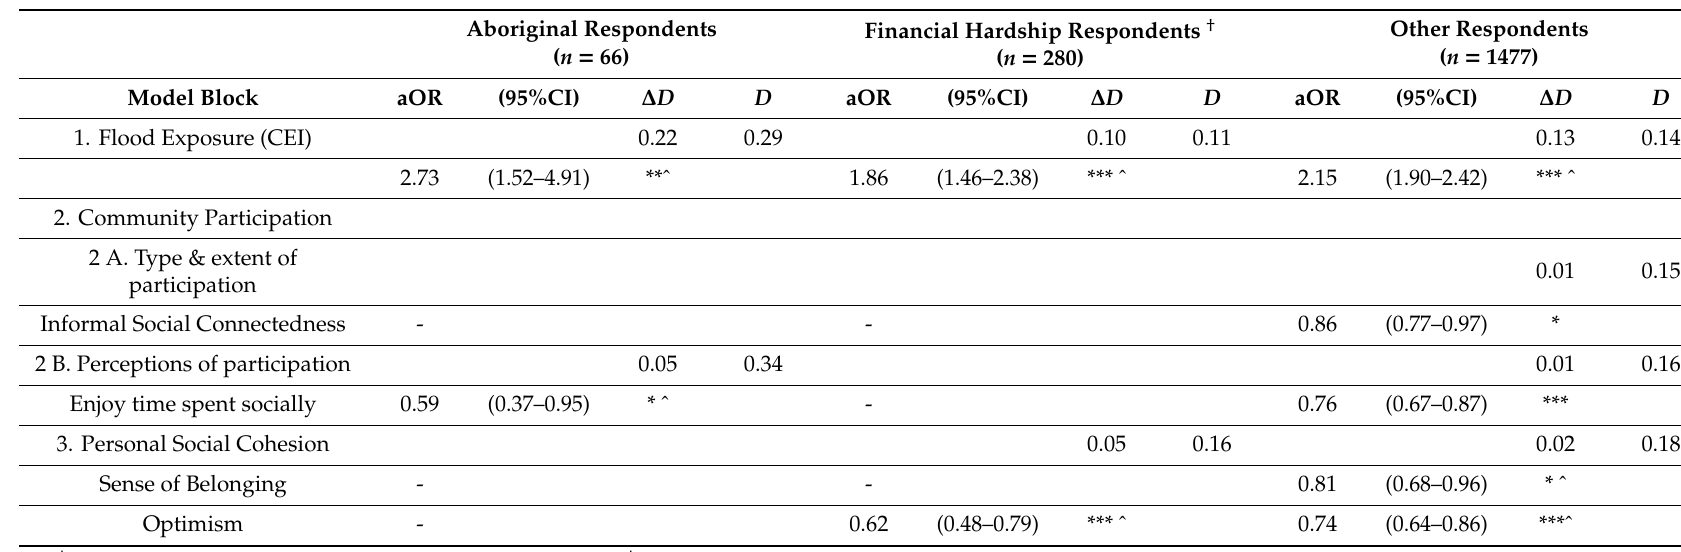
Table 6. Parameter estimates and associated statistics of multiple hierarchical logistic models predicting flood-related ongoing distress for each respondent group, controlling for sociodemographic factors ‡